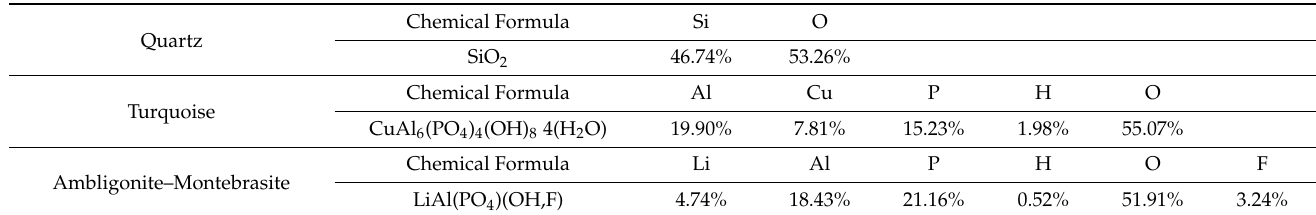
Table 3. Chemical formula and theoretical chemistry of quartz, turquoise, and amblygonite–montebrasite.